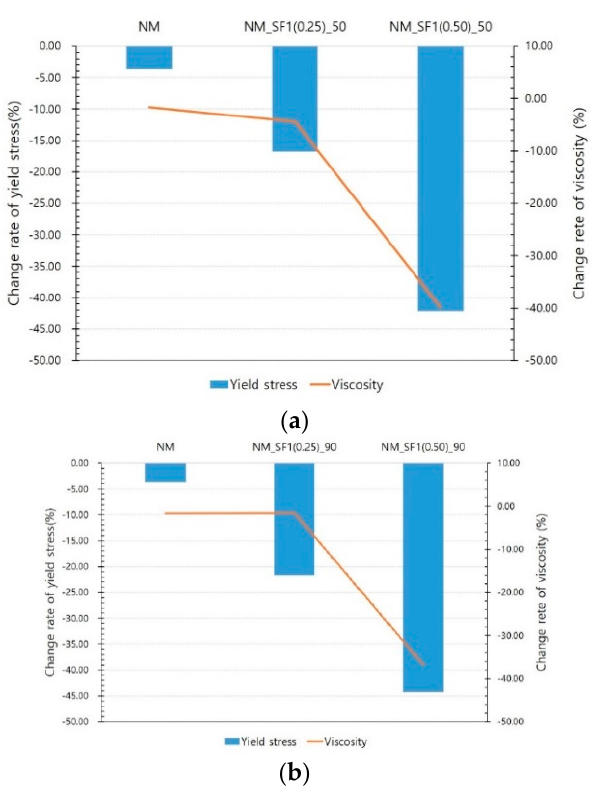
Figure 9. Effect of steel fiber mix ratio: ( a ) at 50 V, ( b ) at 90 V.